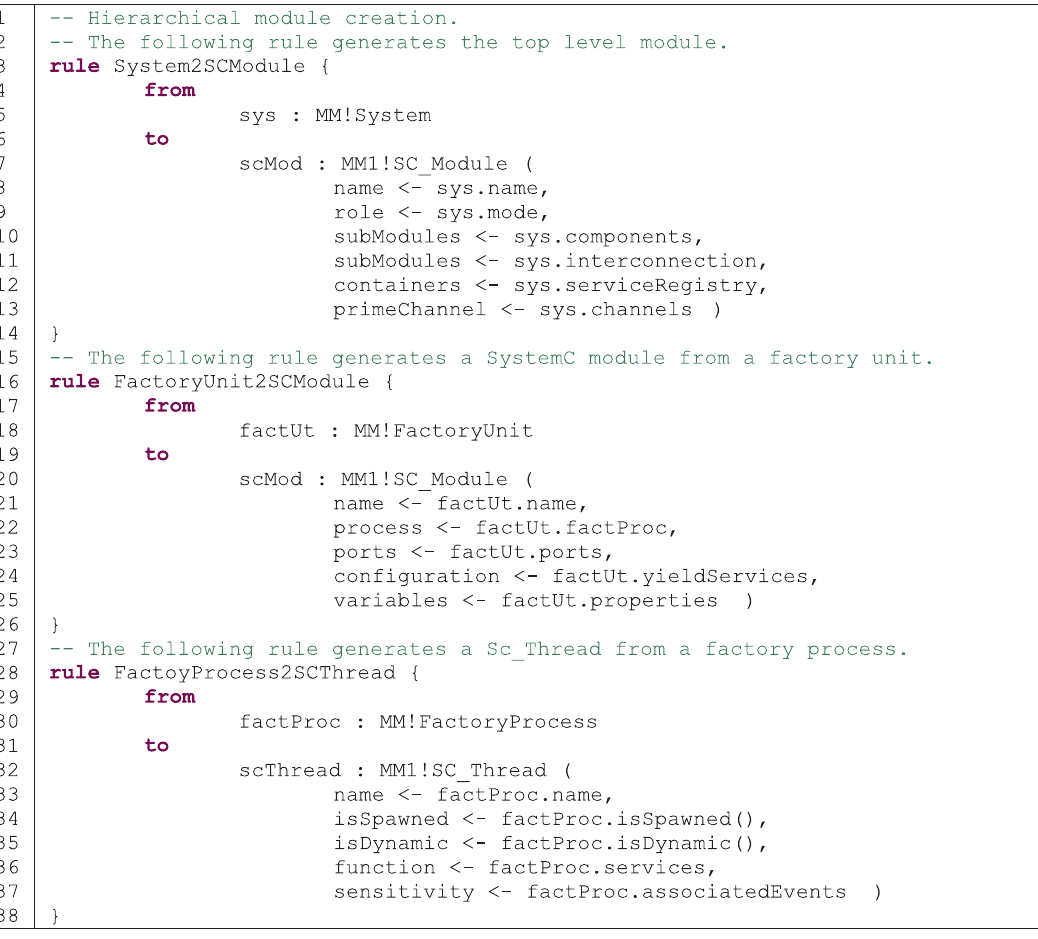
Figure 27: Some ATL transformation